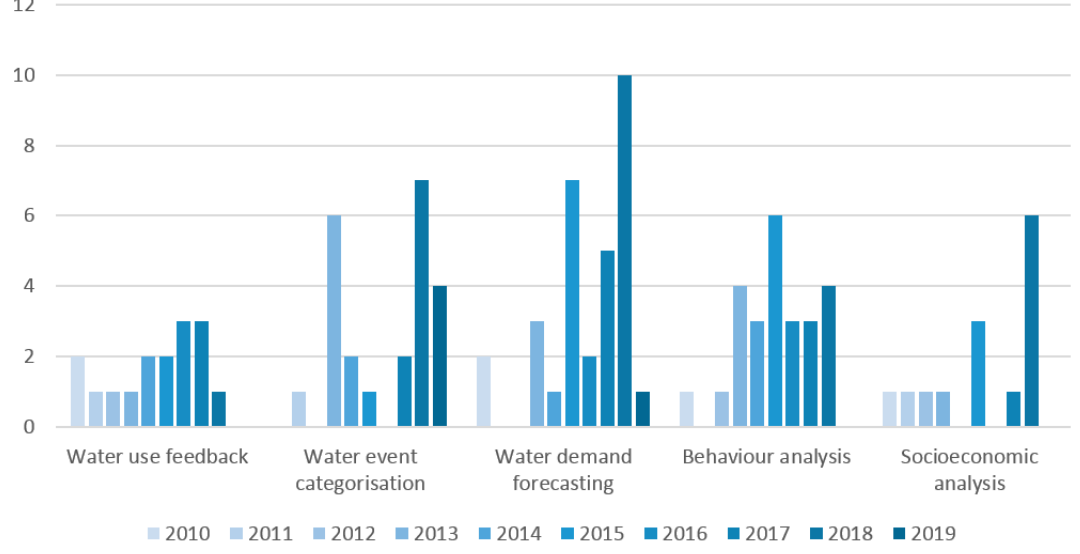
Figure 3. Year-wise distribution of articles for the types of literature.